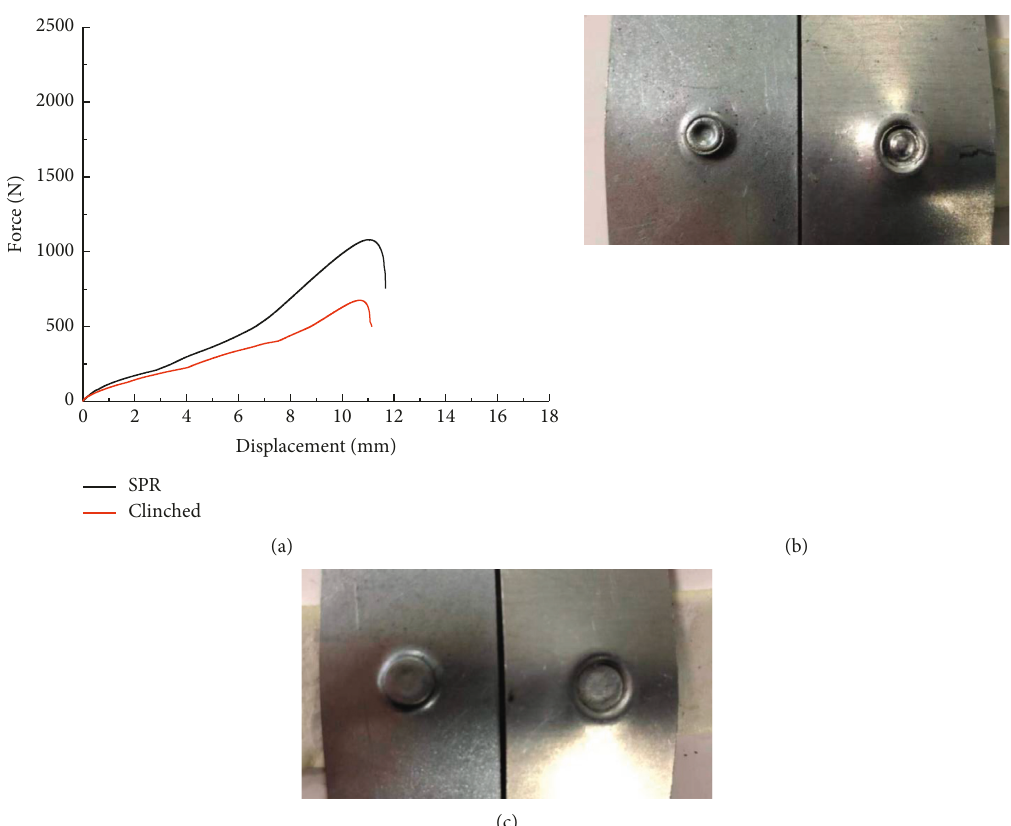
Figure 4: Static cross-tension tests: (a) force-displacement curves, (b) pulling-out failure modes of SPR joint, and (c) clinched joint at 0.083 × 10 − 3